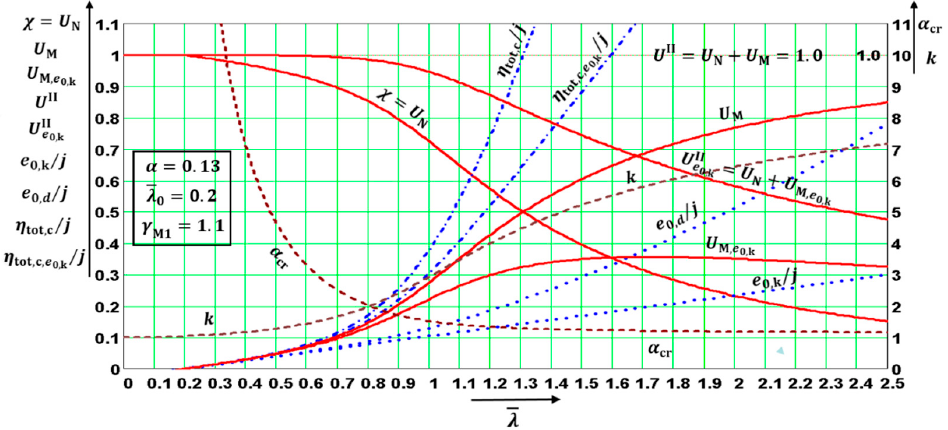
Figure 4. Relevant quantities for α = 0.13, γ M1 = 1.1, and N Ed = N b,Rd = χ Af y / γ M1 . Quantities Figure 4. Relevant quantities for 𝛼 = 0.13, 𝛾 (cid:2897)(cid:2869) = 1.1 , and 𝑁 (cid:2889)(cid:2914) = 𝑁 (cid:2912),(cid:2902)(cid:2914) = 𝜒𝐴𝑓 (cid:2935) 𝛾 (cid:2897)(cid:2869) ⁄ . Quantities Figure 4. Relevant quantities for 𝛼 = 0.13, 𝛾 (cid:2897)(cid:2869) = 1.1 , and 𝑁 (cid:2889)(cid:2914) = 𝑁 (cid:2912),(cid:2902)(cid:2914) = 𝜒𝐴𝑓 (cid:2935) 𝛾 (cid:2897)(cid:2869) ⁄ . Quantities Figure 4. Relevant quantities for 𝛼 = 0.13, 𝛾 (cid:2897)(cid:2869) = 1.1 , and 𝑁 (cid:2889)(cid:2914) = 𝑁 (cid:2912),(cid:2902)(cid:2914) = 𝜒𝐴𝑓 (cid:2935) 𝛾 (cid:2897)(cid:2869) ⁄ . Quantities (cid:2893)(cid:2893) ,𝑒 α cr , k , U M, e (cid:2893)(cid:2893) ,𝑒 , U II e , e 0,d / j , and η tot,c, e are also functions of safety factor γ M1 . 𝑗⁄ ,and 𝜂 ,𝑈 (cid:3032) 𝛼 (cid:2913)(cid:2928) ,𝑘,𝑈 (cid:2897),(cid:3032) 𝑗⁄ ,and 𝜂 ,𝑈 (cid:3032) 𝛼 (cid:2913)(cid:2928) ,𝑘,𝑈 (cid:2897),(cid:3032) (cid:2893)(cid:2893) ,𝑒 (cid:2868),(cid:2914) (cid:2930)(cid:2925)(cid:2930),(cid:2913),(cid:3032) (cid:3116),(cid:3169) are also functions of safety factor 𝛾 (cid:2897)(cid:2869) . 𝑗⁄ ,and 𝜂 (cid:2868),(cid:2914) (cid:2930)(cid:2925)(cid:2930),(cid:2913),(cid:3032) (cid:3116),(cid:3169) are also functions of safety factor 𝛾 (cid:2897)(cid:2869) . ,𝑈 (cid:3032) 𝛼 (cid:2913)(cid:2928) ,𝑘,𝑈 (cid:2897),(cid:3032) 0,k 0,k 0,k (cid:3116),(cid:3169) (cid:3116),(cid:3169) (cid:3116),(cid:3169) (cid:3116),(cid:3169) (cid:2868),(cid:2914) (cid:2930)(cid:2925)(cid:2930),(cid:2913),(cid:3032) (cid:3116),(cid:3169) are also functions of safety factor 𝛾 (cid:2897)(cid:2869) . (cid:3116),(cid:3169) (cid:3116),(cid:3169)